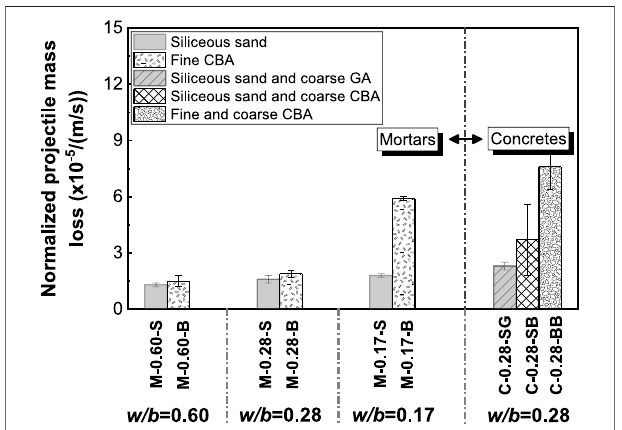
FIGURE 13 | Effect of CBA on the CV of cement composites subjected to deformable copper HVPI.